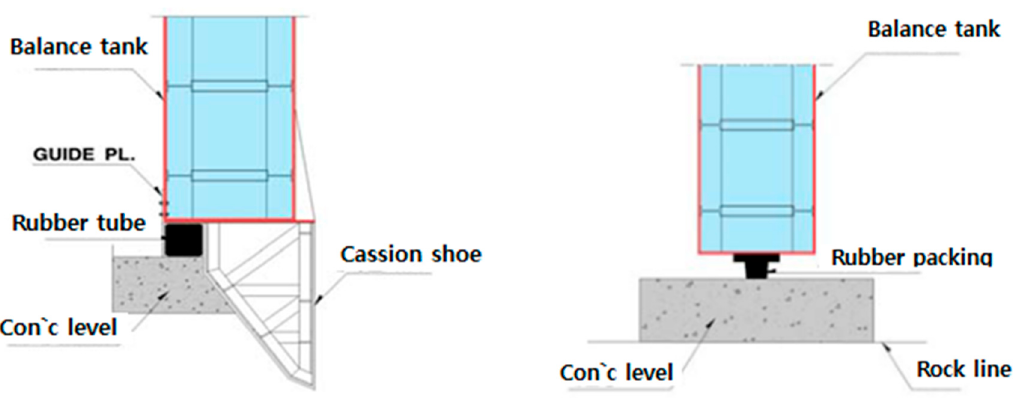
Figure 2. Schematic of C.T cofferdam method.